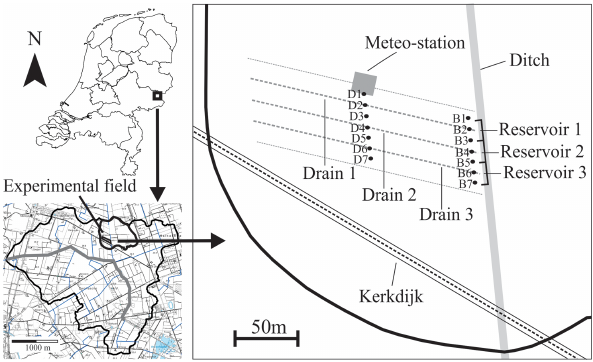
Figure 1. Location of the Hupsel catchment and the experimental field. The field sketch shows the three measured tube drains, the location of the in-stream reservoirs, and the locations of the con- tinuous groundwater level recording in transects at 5m from the ditch (B1–B7) and at 80m from the ditch (D1–D7).